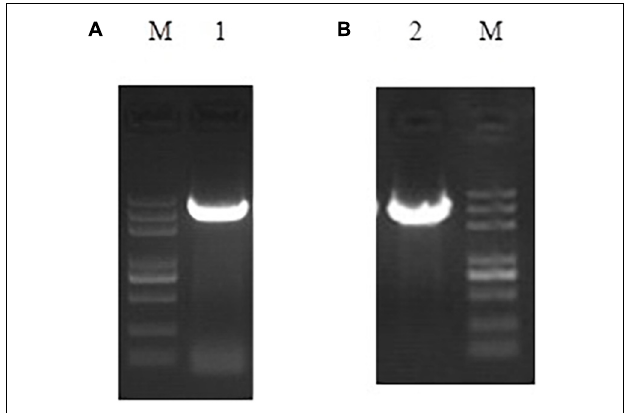
FIGURE 1 | Full-length PCR amplification results of niiA (A) and niaD (B) .